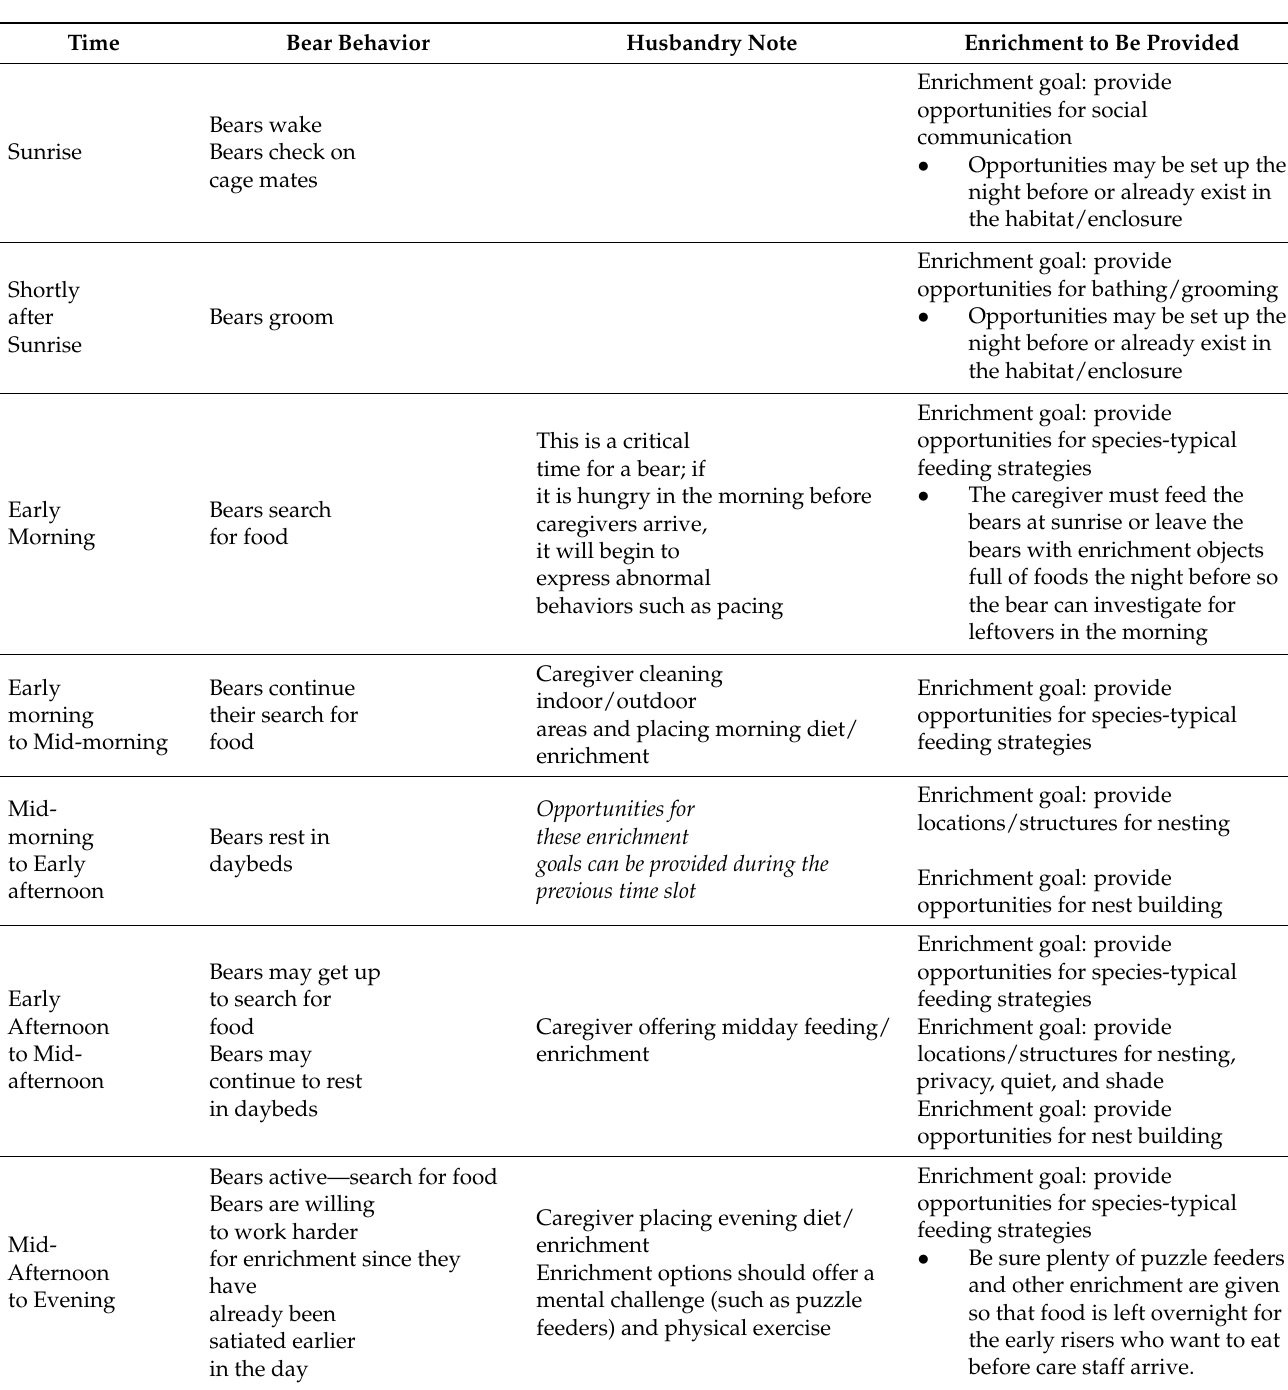
Table 2. An example of how enrichment may be provided throughout the daily routine of a sloth